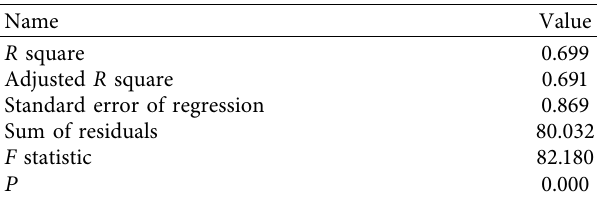
Table 11: Statistics of the adjusted quadratic models (mean velocity variation in a certain window